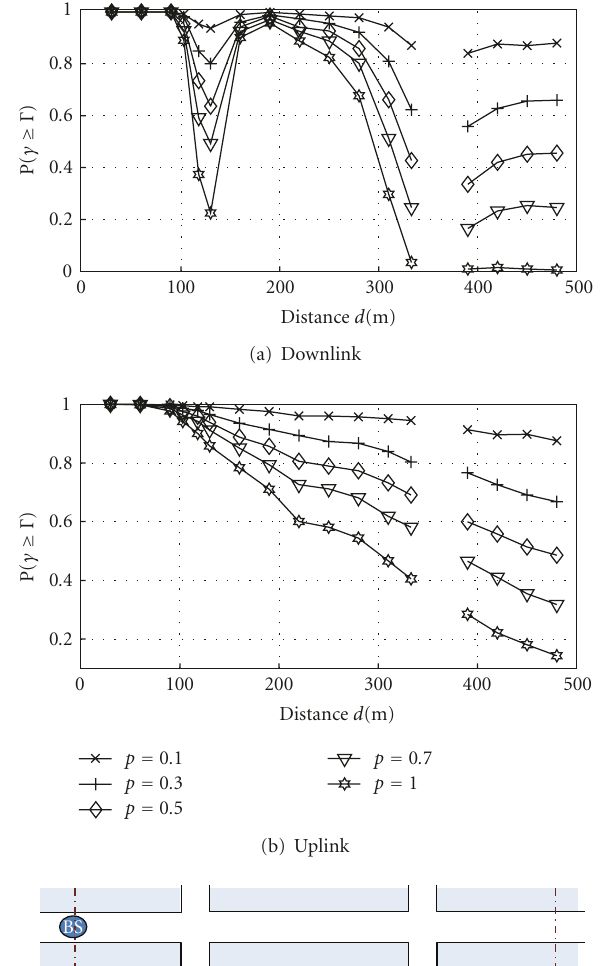
Figure 5: Probability of meeting the SINR target Γ = 11 . 3 dB in contention for di ff erent access probabilities p , as a function of the BS-MS distance d . At d = 115 m, links are exposed to strong LOS interference from cells in perpendicular streets, which causes collisions in the downlink, while at d = 345 m, the MSs are connected to BSs in a perpendicular street due to better channel gains.